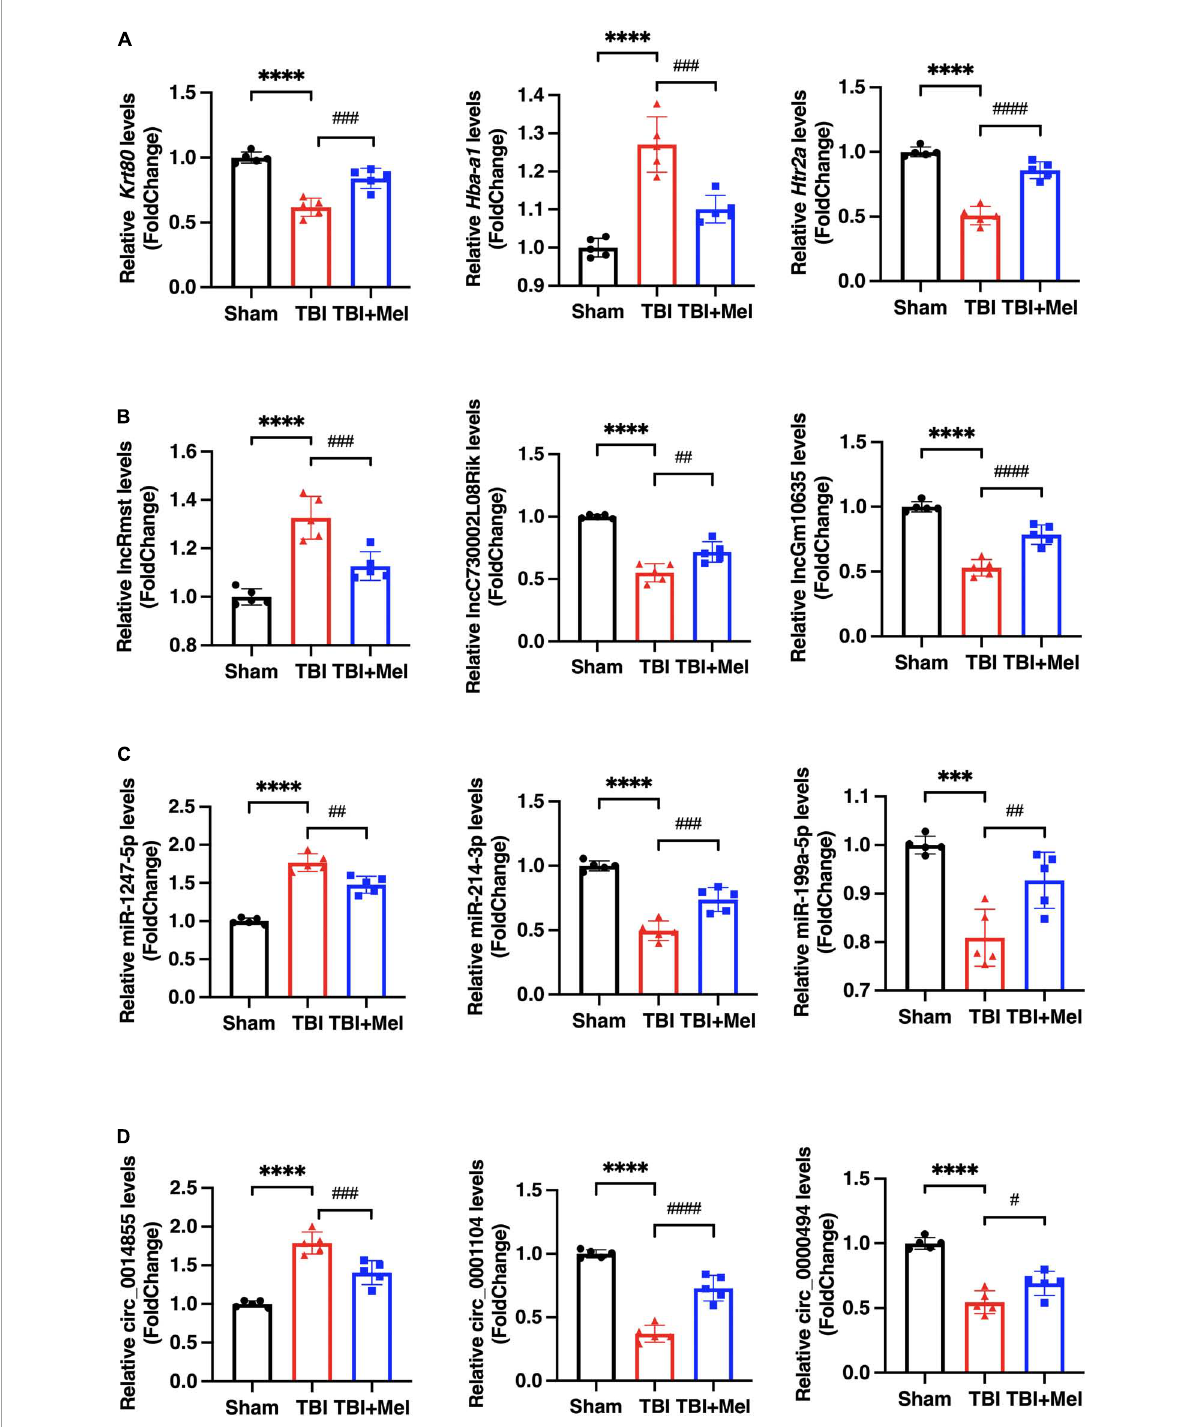
FIGURE3 The differential expression of DEmRNAs, DElncRNAs, DEmiRNAs, and DEcircRNAs were validated by qRT-PCR. (A) Representative differentially expressed mRNAs (DEmRNAs), Krt80, Hba-a1, and Htr2a, were detected by qPCR. (B) Representative differentially expressed lncRNAs (DElncRNAs), lncRmst, lncC730002L08Rik, and lncGm10635, were detected by qPCR. (C) Representative differentially expressed miRNAs (DEmiRNAs), miR-1247-5p, miR-214-3p, and miR-199a-5p, were detected by qPCR. (D) Representative differentially expressed circRNAs (DEcircRNAs), circ_0014855, circ_0001104, and circ_0000494, were detected by qPCR. The data were presented using mean ± SD, *** p < 0.001, and **** p < 0.0001 TBI vs. Sham; # p < 0.05, ## p < 0.01, ### p < 0.001, and #### p < 0.0001 TBI + Mel vs. TBI, one-way ANOVA followed by Tukey’s